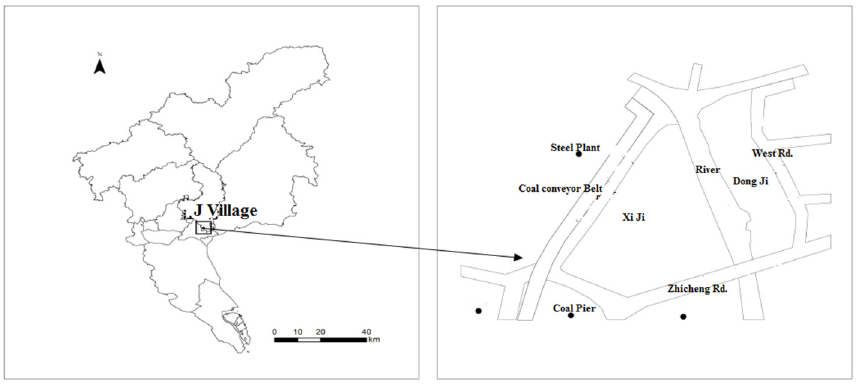
Figure 1. Location and map of J village.